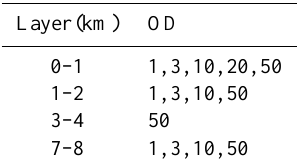
Table 2. Summary of all modelled geometries for which the thresh- old parametrization is performed. The solar zenith angle (SZA), rel- ative azimuth angle (RAA), and viewing zenith angle (VZA) are defined in the satellite system, respectively.